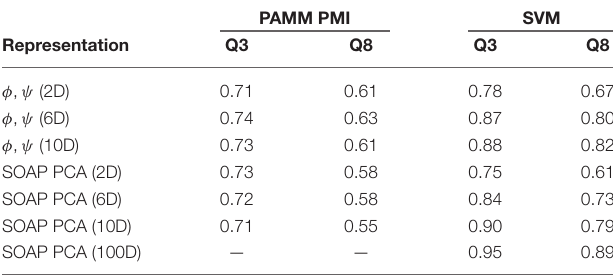
TABLE 3 | Q3 and Q8 scores relative to DSSP for PAMM PMI and SVM predictions of secondary structure based on a PCA of SOAP vectors and dihedral angles at various